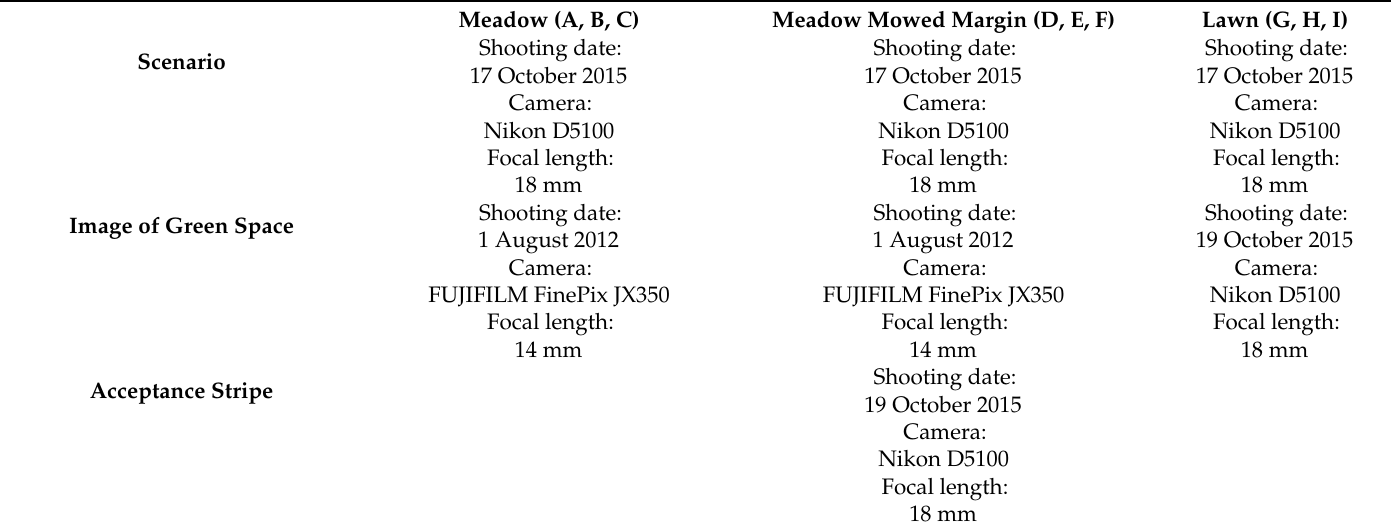
Table A8. Photo usage and details of Question